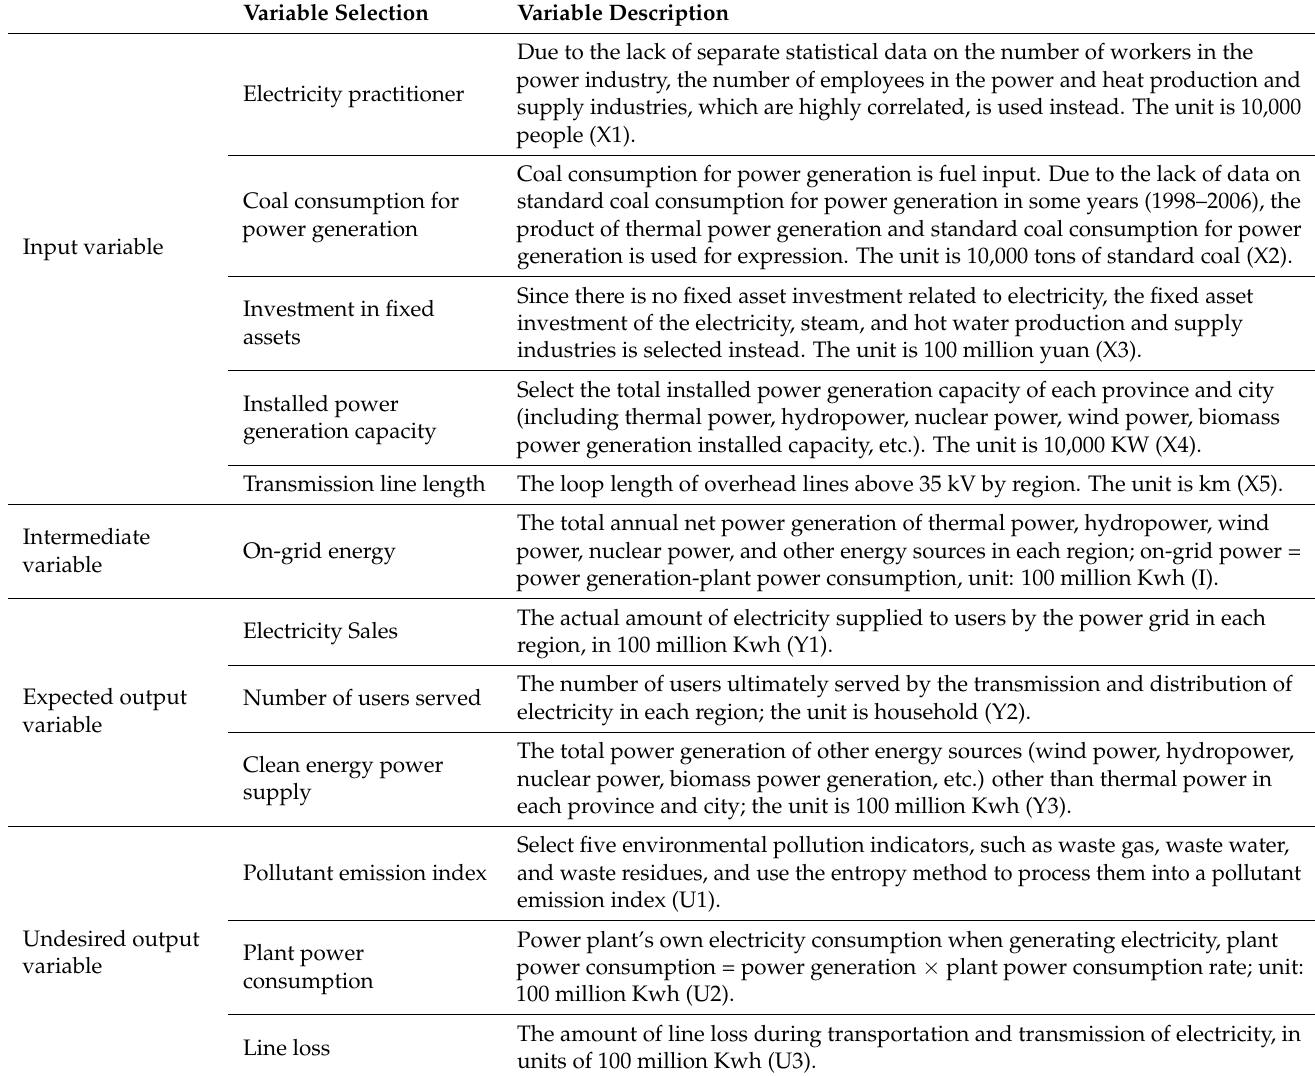
Table 1. Construction of power system input-output indicator